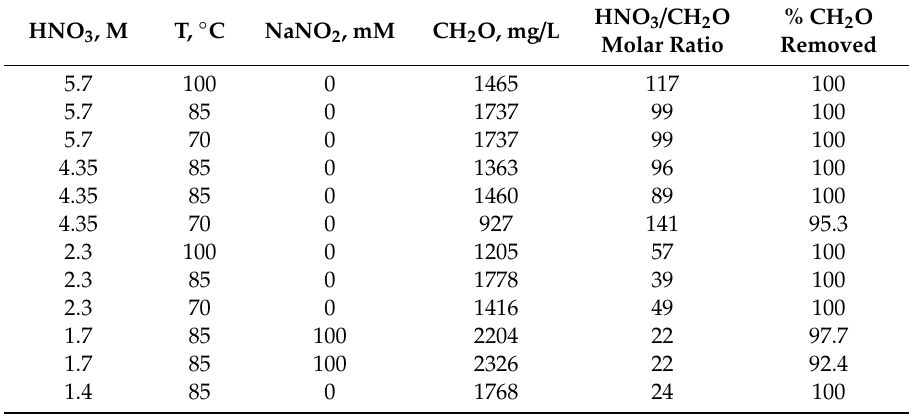
Table 4. Formaldehyde removal achieved by varying nitric acid concentration, temperature, sodium nitrite and formaldehyde concentration, working with industrial